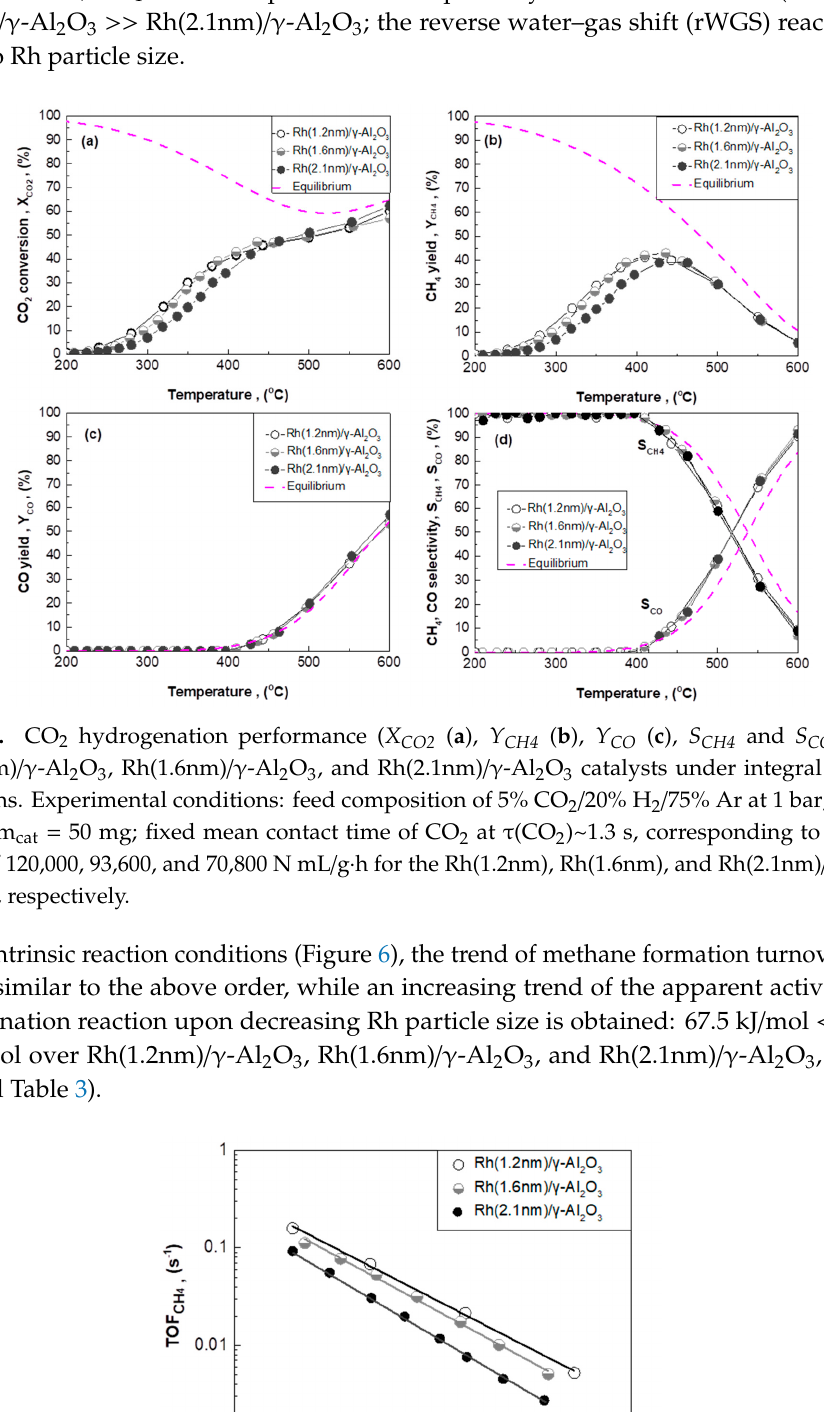
Figure 6. Arrhenius plots of the CH 4 formation turnover frequency ( TOF CH4 ) obtained for Rh/ γ -Al 2 O 3 catalysts with different mean Rh particle size. Experimental conditions as in Figure 5.